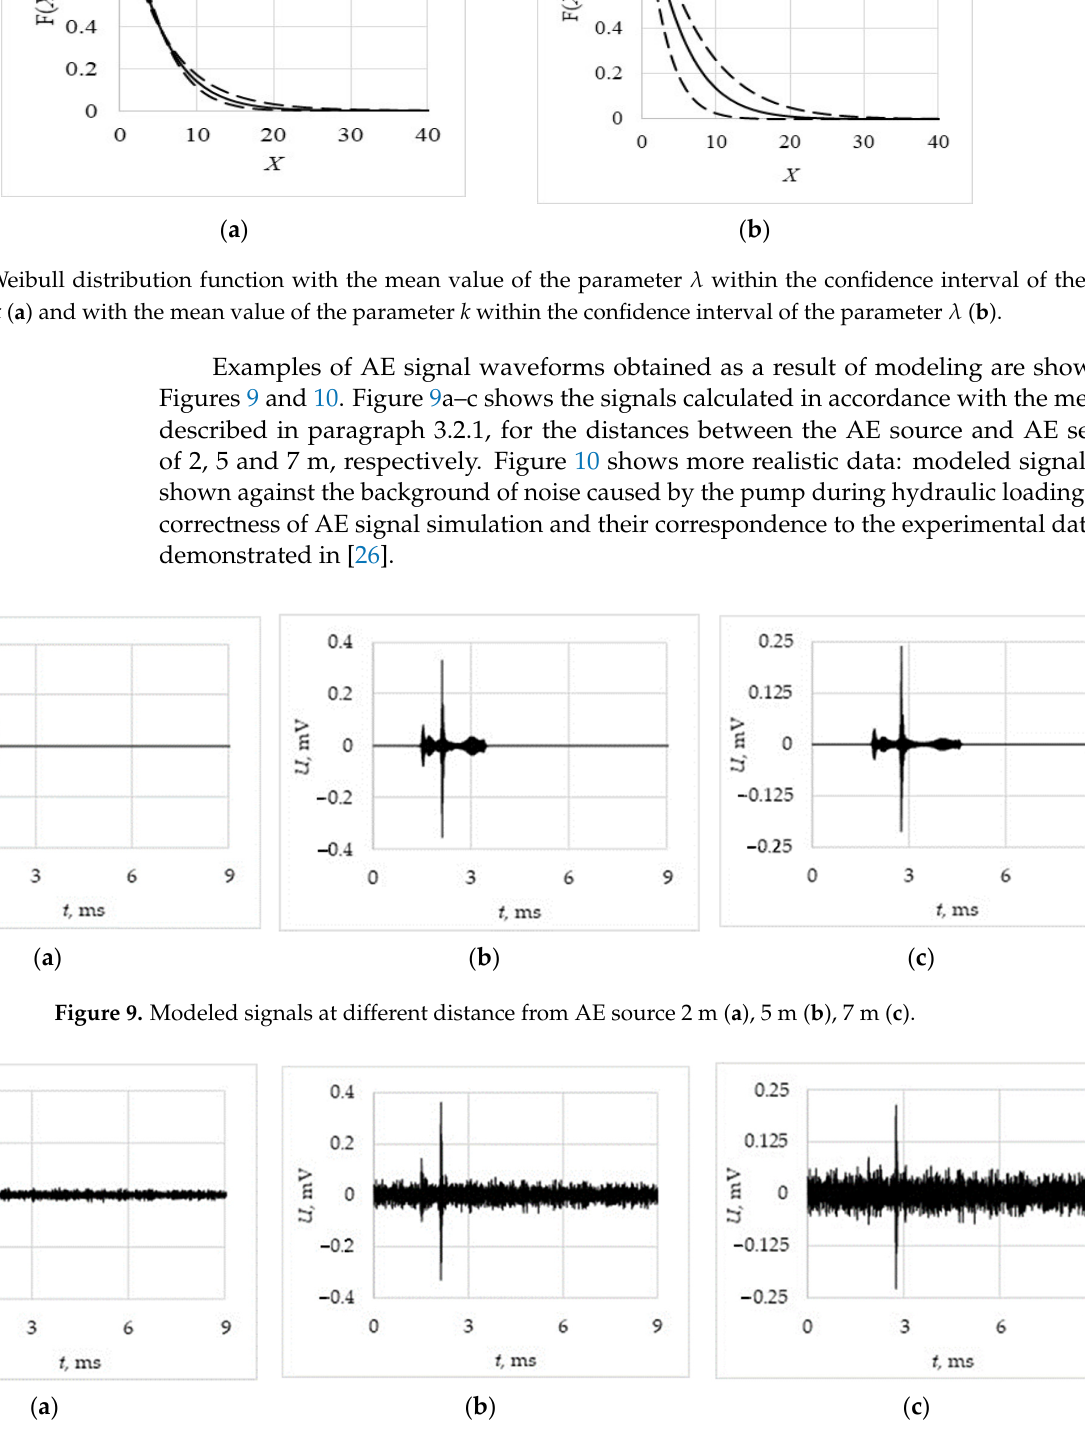
Figure 10. Modeled signals against noise caused by compressor at different distance from AE source 2 m ( a ), 5 m ( b ), 7 m ( c ).